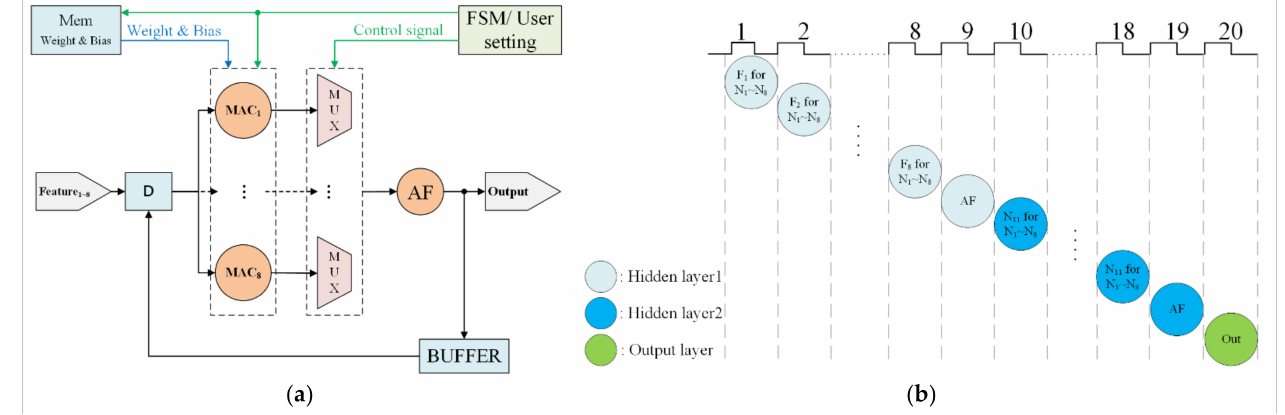
Figure 2. ANN algorithm implementation. ( a ) Block diagram of ANN. ( b ) Scheduling of the ANN processing.